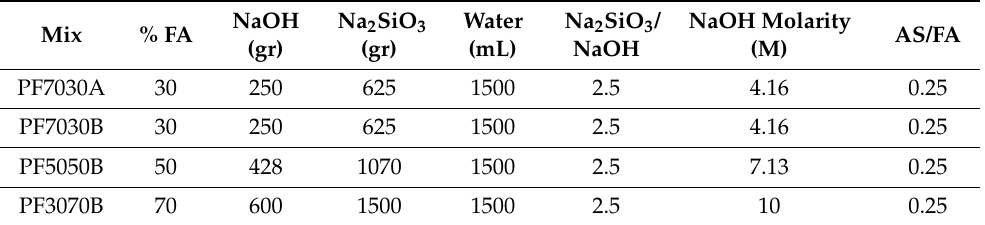
Table 12. The details of concrete mixtures with different ratios of AS for dosages of 30%, 50%, 70% FA.